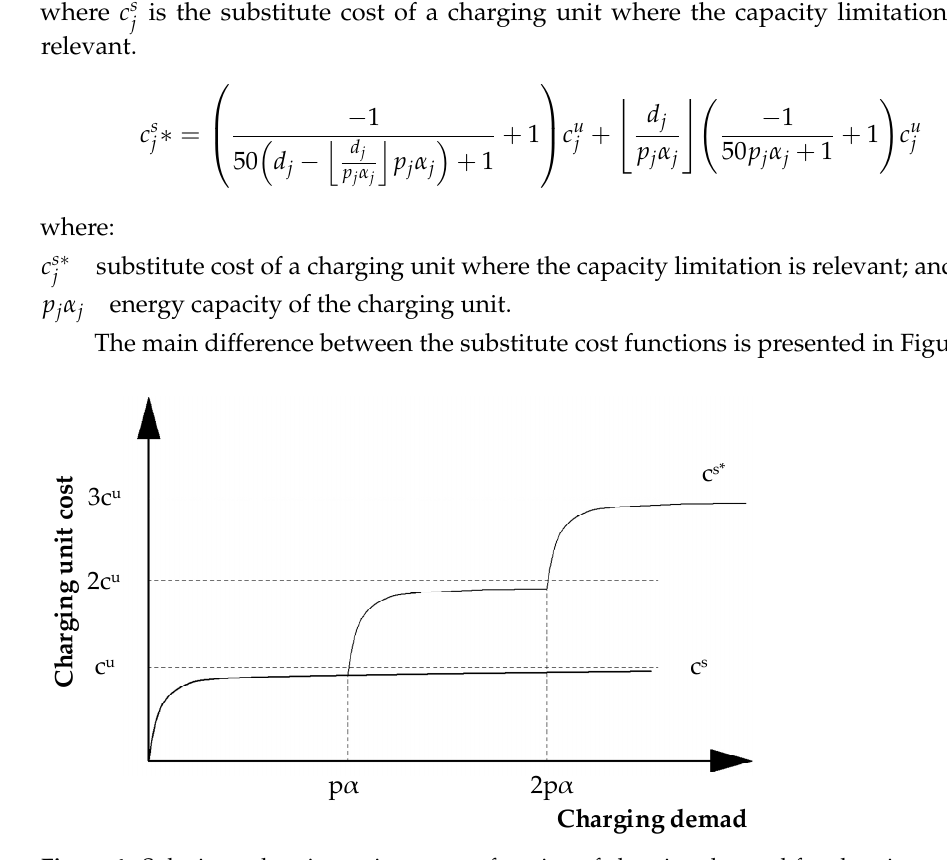
Figure 4. Substitute charging unit cost as a function of charging demand for charging unit with infinite ( c s ) and limited capacity ( c s * ).